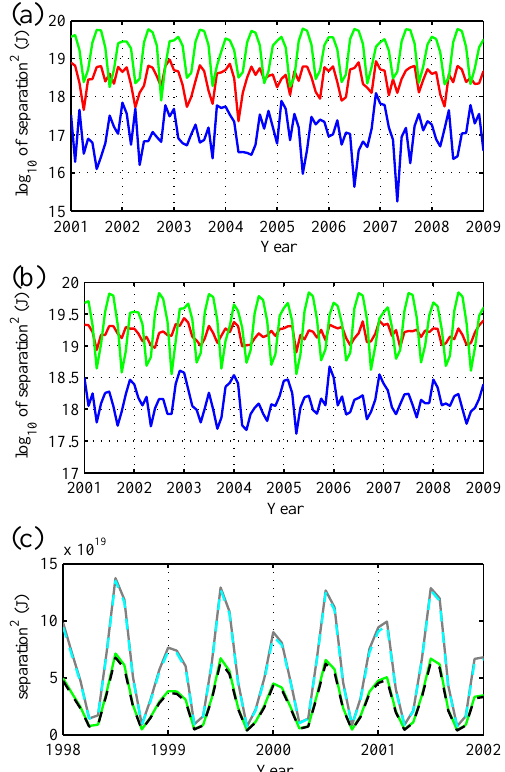
Figure 5. (a) Kinetic (red), enthalpy (green) and surface pres- sure (blue) separation-squared between CFSR zonal mean monthly mean data and its annual mean climatology in mid-latitudes (35– 65 ◦ N) up to 100mb. (b) As (a) , but using full 3-D data includ- ing the eddies. (c) Enthalpy separation-squared calculated with dif- ferent formulae: as the author proposed (green solid line), using constant temperature T o = 270K in the integrand c p (δT ) 2 /( 4 T o ) (black dashed line), further multiplying by a factor of 2 to get c p (δT ) 2 /( 2 T o ) (cyan dashed line), and using constant p o = 1000mb instead of p r (x,y) for the integration upper limit but ex- cluding isobars below the surface (grey solid line). Note that the vertical scale is logarithmic in (a, b) but is linear in (c)